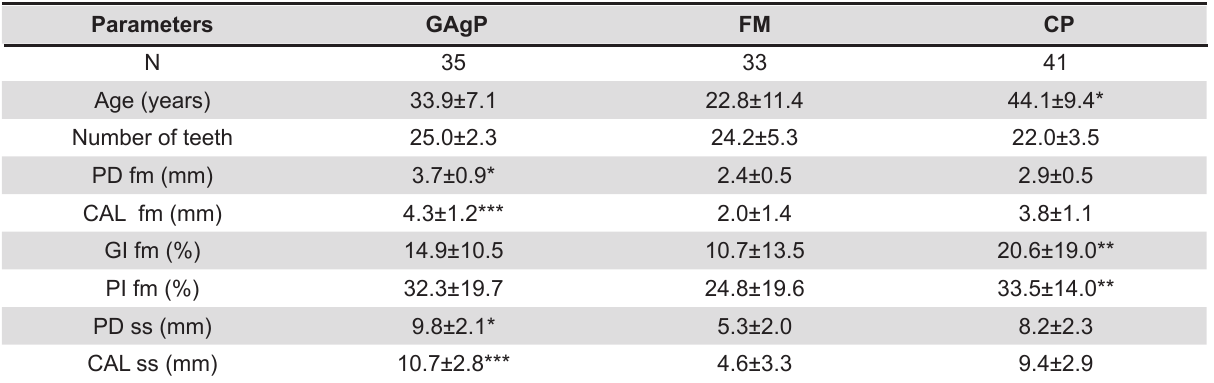
Table 1- Clinical periodontal parameters (mean± standard deviation) of subjects with generalized aggressive periodontitis (GAgP), chronic periodontitis (CP), and their family members (FM)